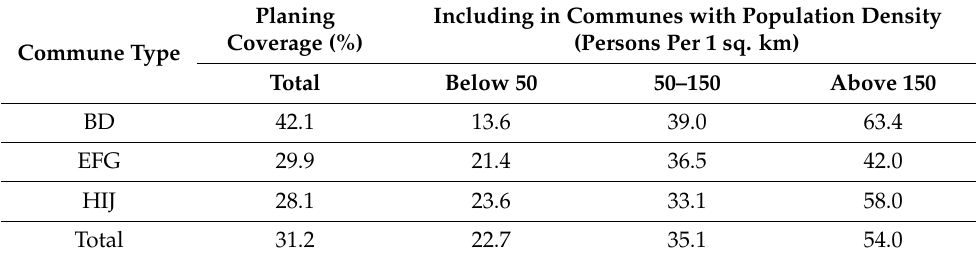
Figure 2. Planning coverage in Poland, for the year 2019. Source: based on data from the Ministry of Development and Central Statistical Office of Poland. Table 2. Planning coverage by commune type and by population density, for the year